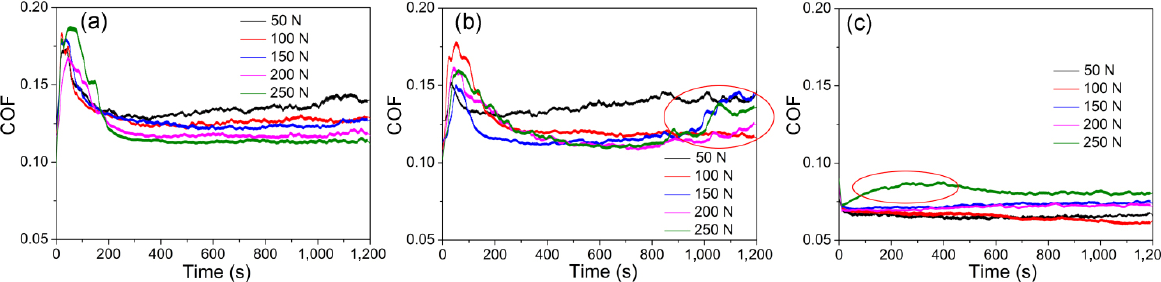
Fig. 10 COF curves lubricated with (a) PEG200, and (b) A-g-CNPs and (c) C-g-CNPs dispersions (0.7 wt%) in PEG200 under the conditions of 50–250 N and 20 min.